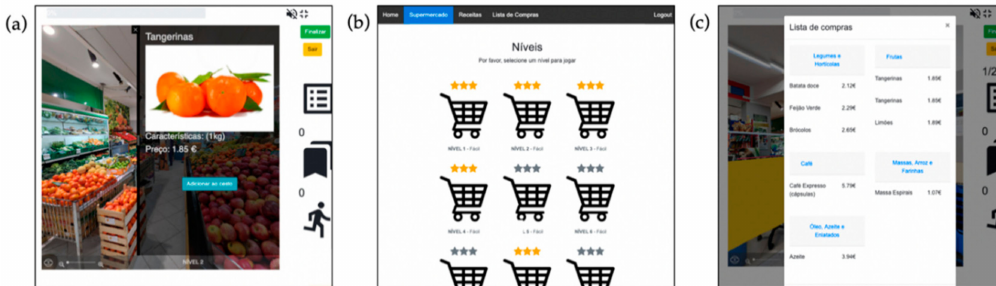
Figure 1. Interface elements of the NeuroVRehab.PT neurorehabilitation digital platform.